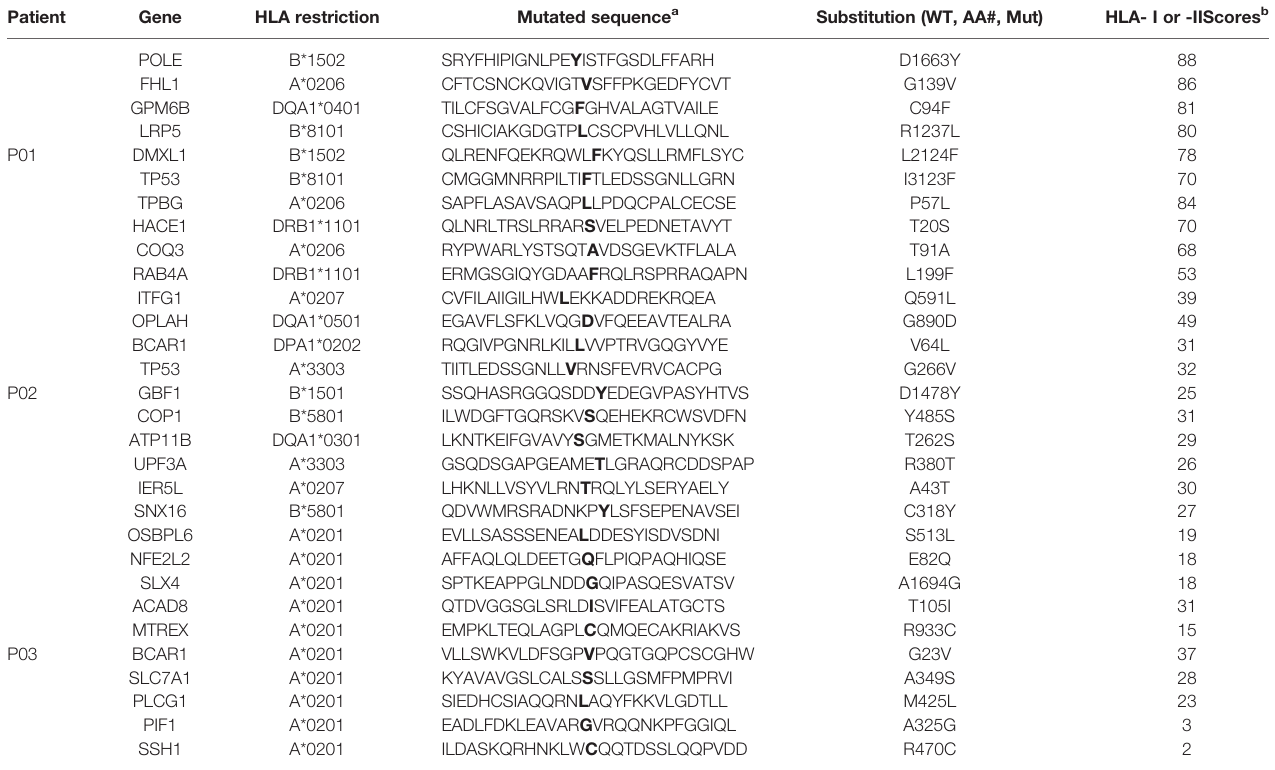
TABLE 1 | In silico prediction of mutations of three NSCLC patients with favorable HLA class I or II binding properties.